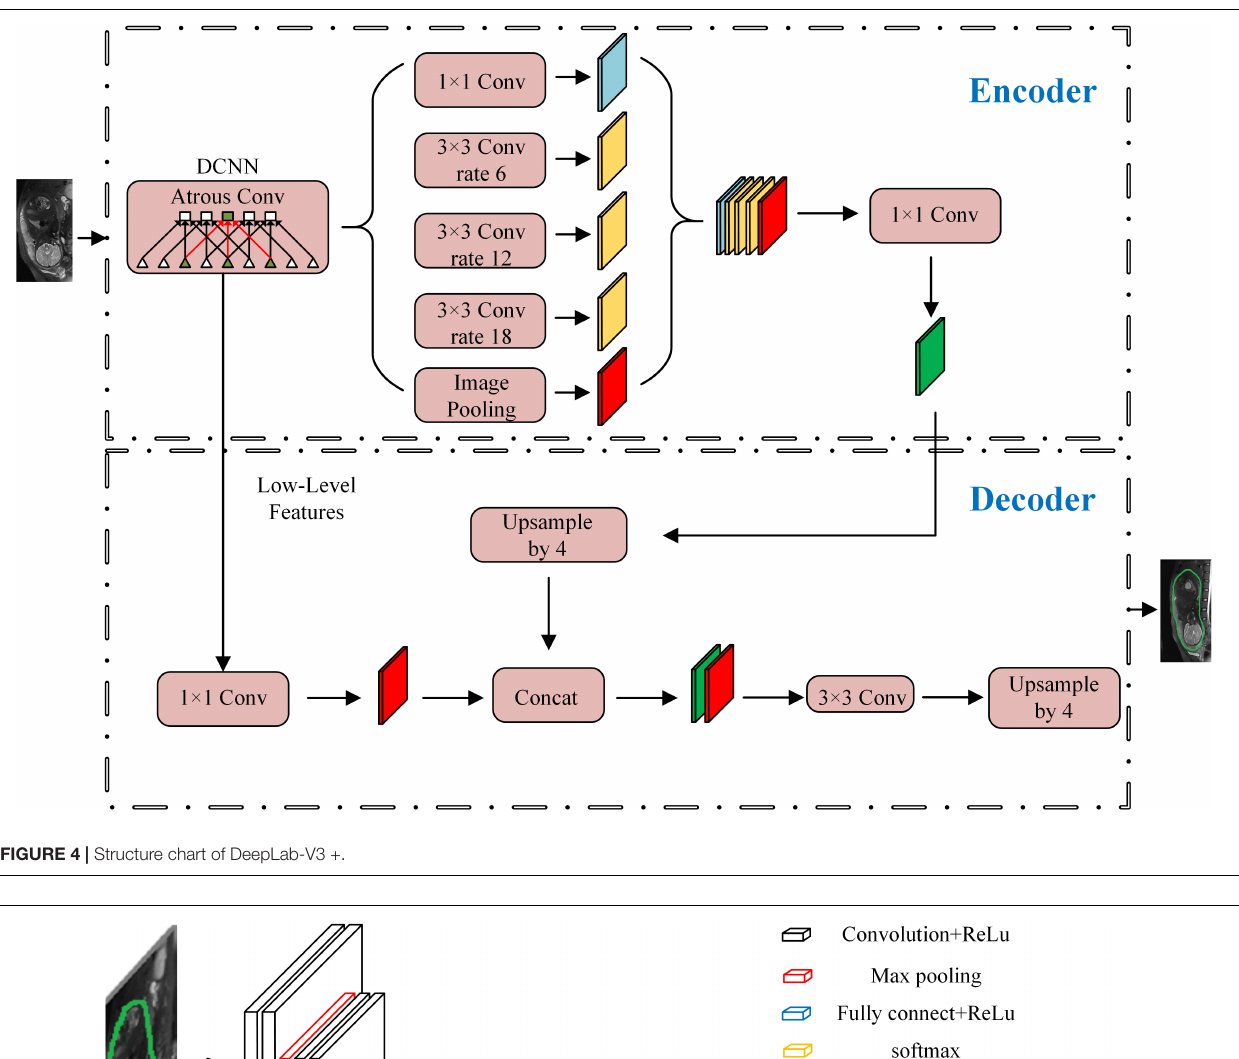
FIGURE 5 | Structure chart of